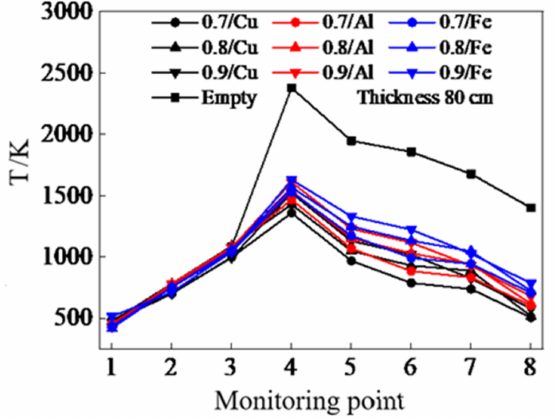
Figure 20. Maximum temperature at each monitoring